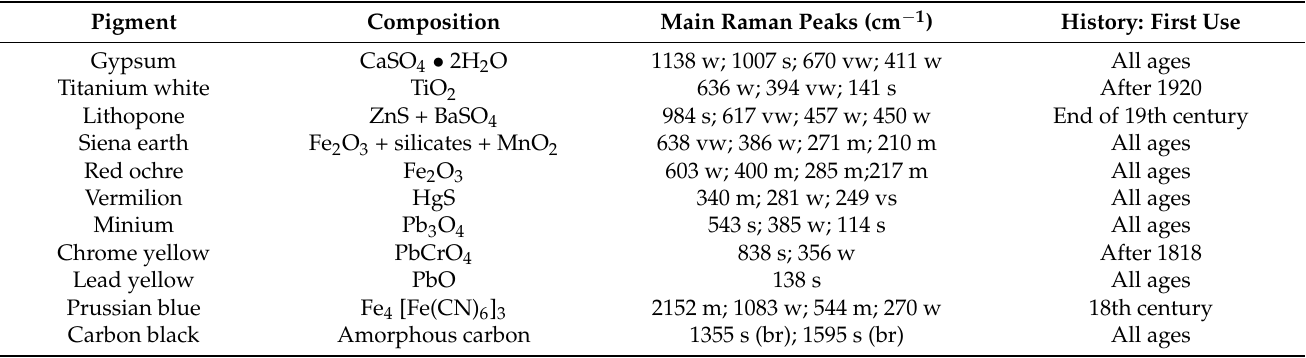
Table 2. List of all pigments found using micro-Raman spectroscopy analysis with the historic records of use and the principal Raman peaks.